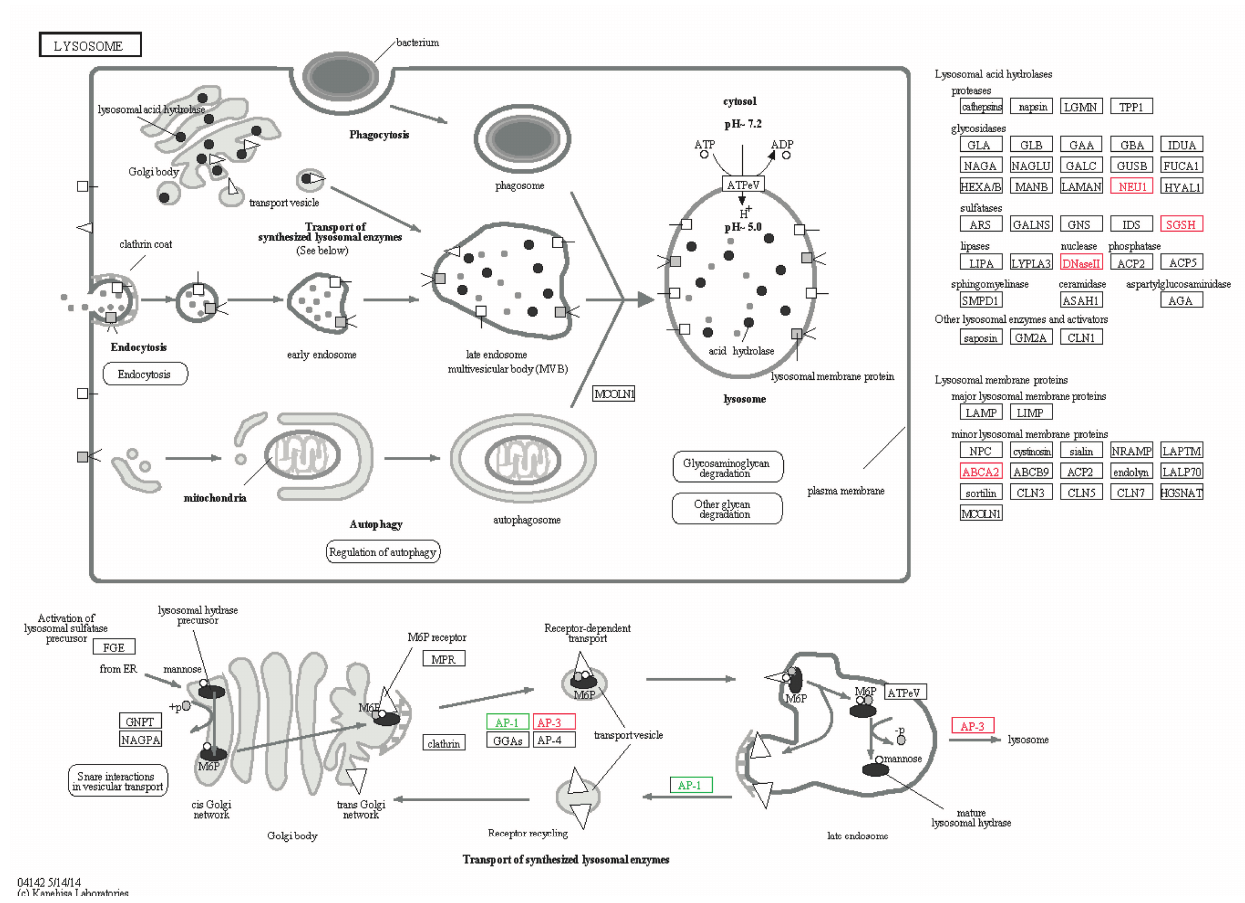
Figure 12. Lysosome signaling pathway. Red boxes represent up-regulated genes, and green boxes represent down-regulated